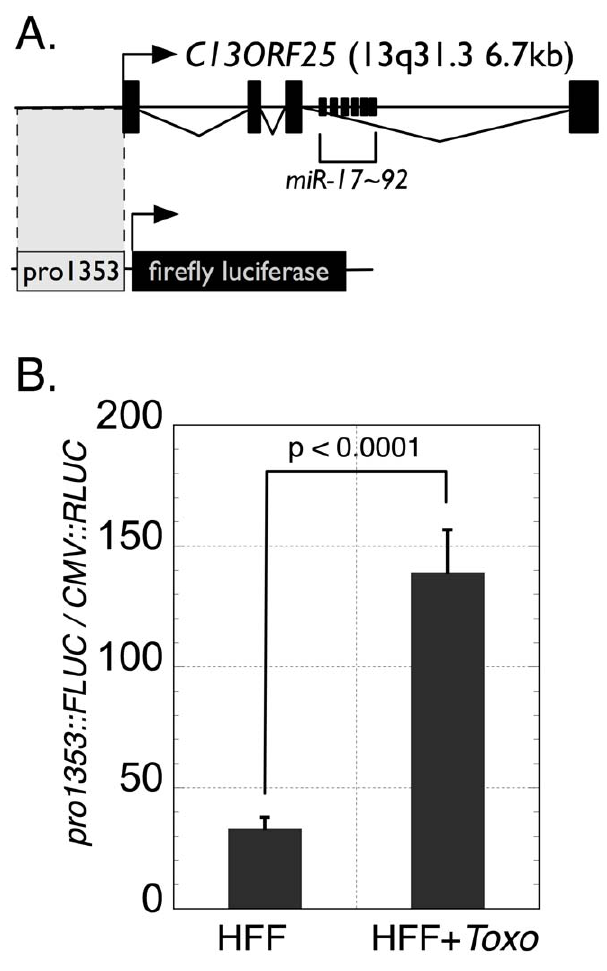
Figure 5. Toxoplasma infection increases pri-miR-17 , 92 transcription. (A) Diagram of the location of the pro1353 fragment and its position relative to the transcribed portion of C13ORF25 . Transcription start sites of C13ORF25 and pro1353::FLUC are shown by bent arrows. The pro1353 fragment overlaps the 5 9 -end of the C13ORF25 EST by 10 nucleotides [38]. (B) pro1353::FLUC / CMV::RLUC ratios for uninfected HFFs or Toxoplasma -infected HFFs (HFF + Toxo ) are plotted. Shown are five biological replicates for each condition from a representative experiment.